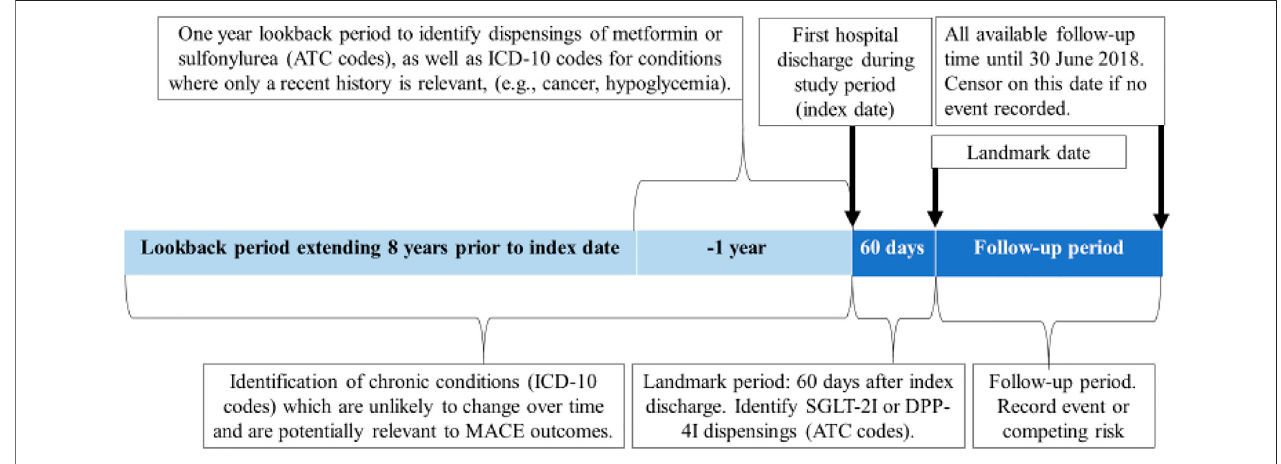
FIGURE 1 | An illustration depicting the study design.